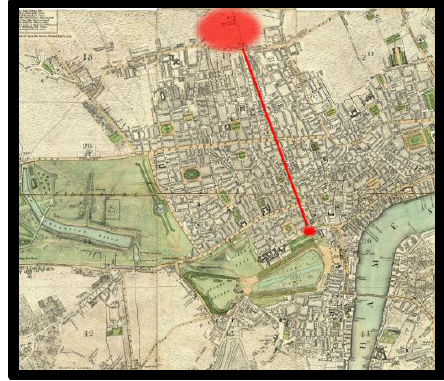
Figure 3 : Faden, W. (1814). Plan of a street. (URL